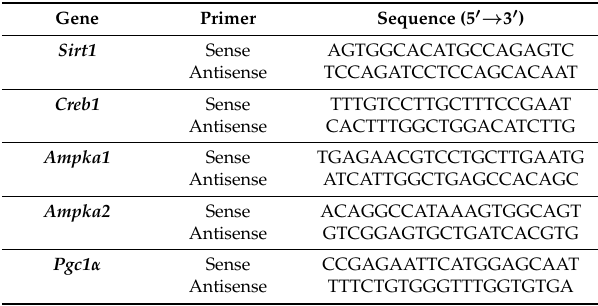
Table 2. Primers used for real-time